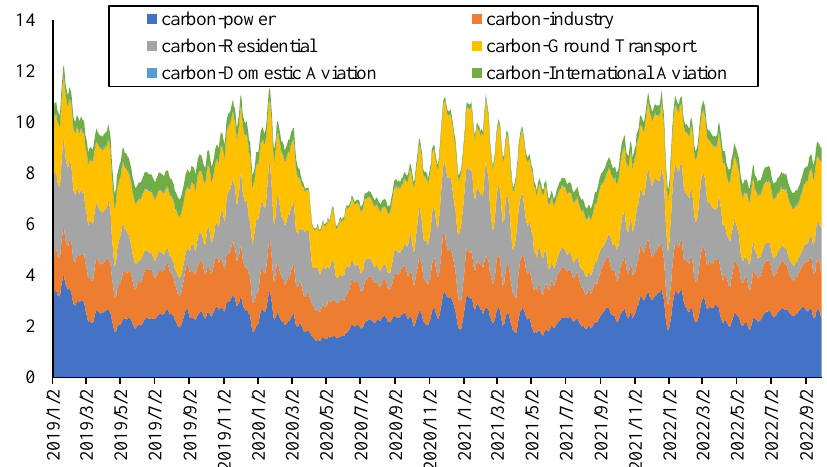
Figure 2. Crude oil price, natural gas price and carbon price.